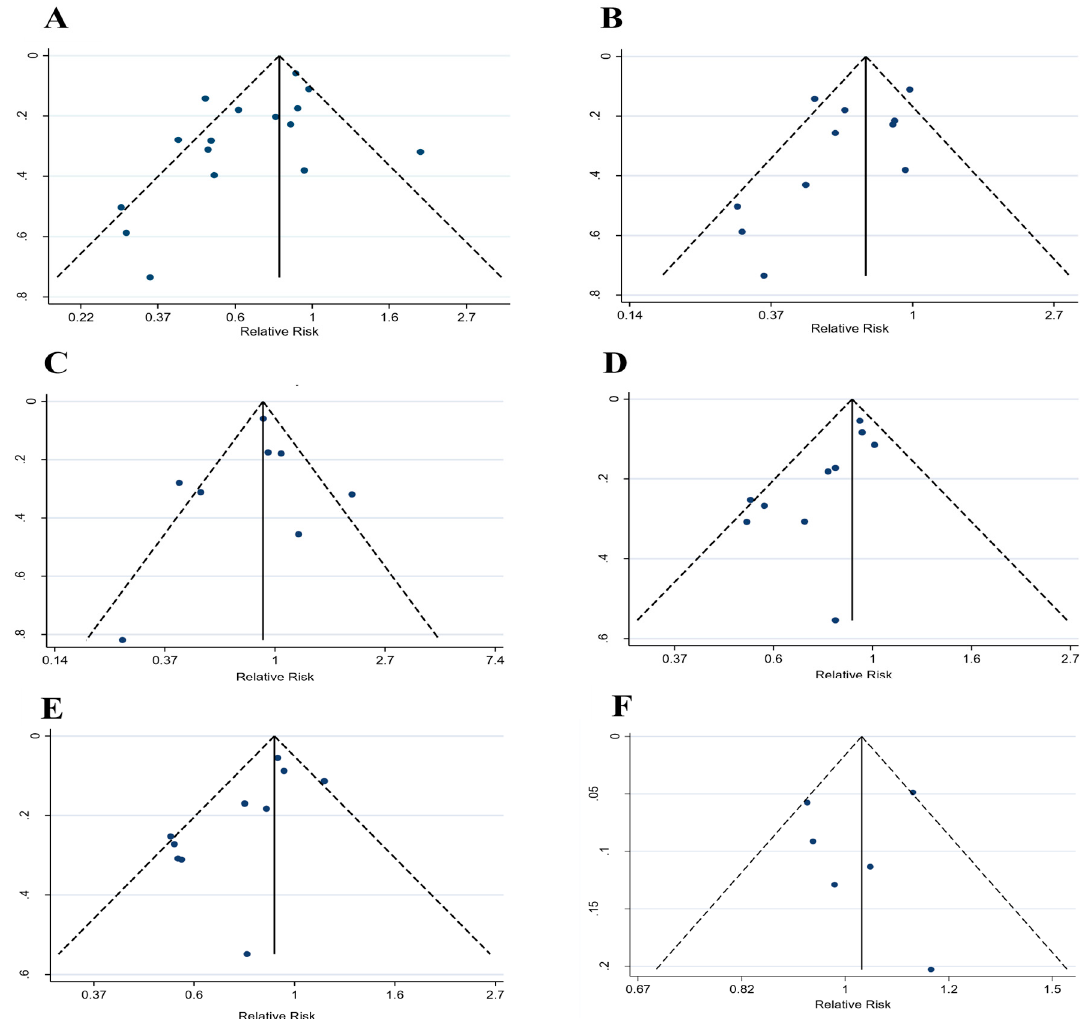
Figure A1. Funnel plots for ( A ) total soy intake and risk of prostate cancer; ( B ) unfermented soy intake and risk of prostate cancer; ( C ) fermented soy intake and risk of prostate cancer; ( D ) genistein intake and risk of prostate cancer; ( E ) daidzein intake and risk of prostate cancer; and ( F ) total isoflavone intake and risk of prostate cancer.